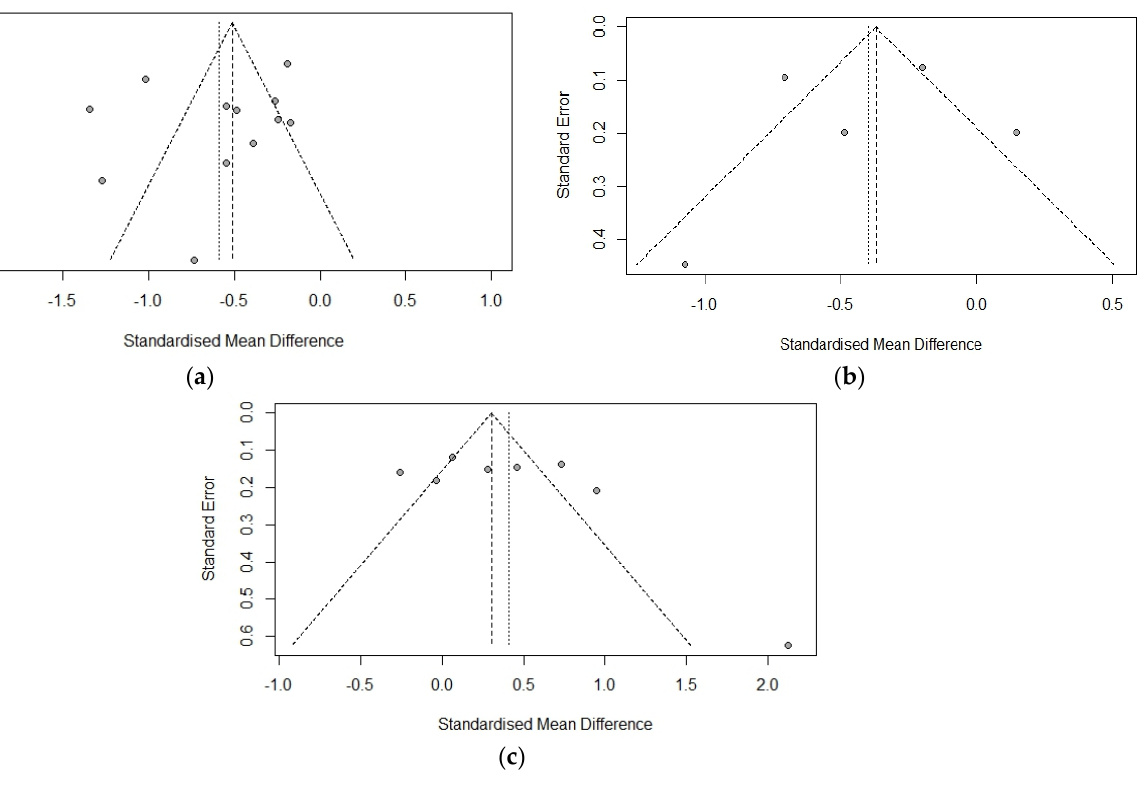
Figure 3. Funnel plot for publication bias analysis for vitamin D levels between ( a ) CHB patients and healthy controls ( b ) HBeAg ‐ positive and negative CHB patients ( c ) CHB patients with or without liver disease.